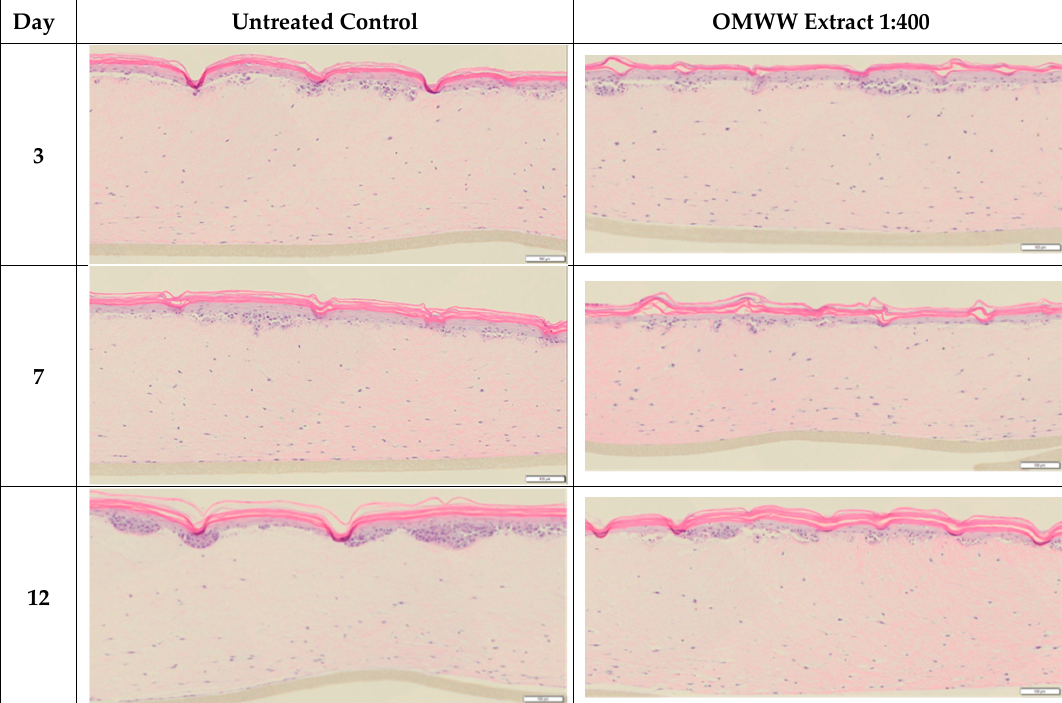
Figure 7. Results of the tumor invasion investigation of the MatTek Melanoma skin model.